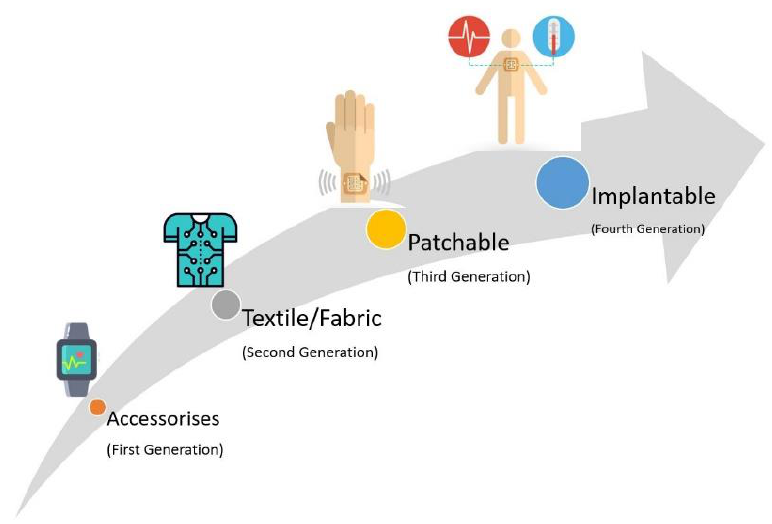
Figure 1. Level of integration with the body for wearable technology products.